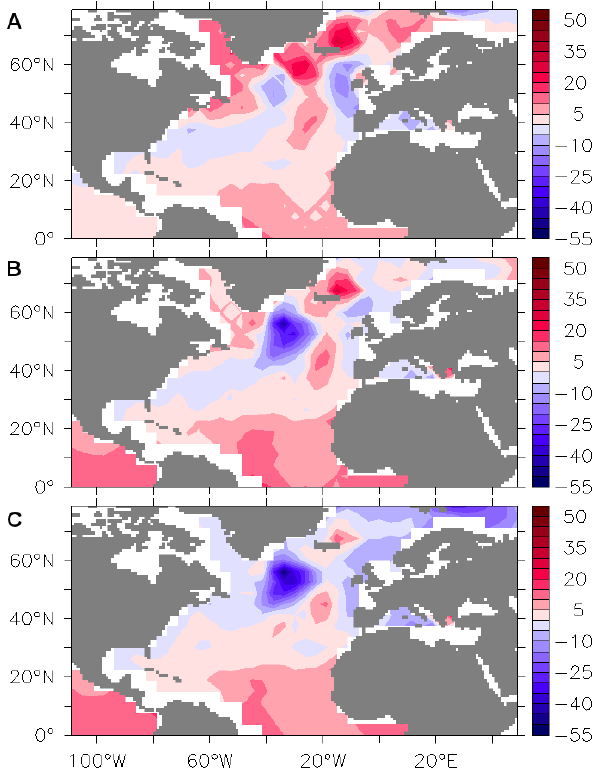
Fig. 7. Sea-level anomaly (zero global mean) in cm for linearly increasing CO 2 concentration (to 1120 ppm within 100yr) at three different times: (A) year 100, (B) year 500, (C) year 1000. Fig. 8. (A) AMOC maximum, and (B) sea-level anomaly at the North American coast (zero global mean). CO 2 concentration is linearly increased to 1120 ppm within the first 100 yr.